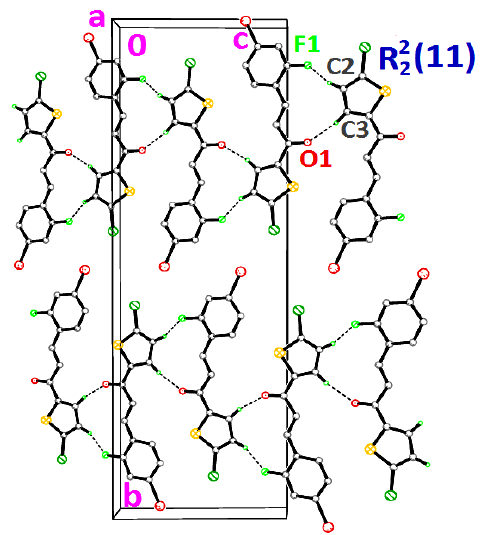
Figure 8. Crystal structure of 3f , showing the chains along the c -axis. Dashed lines indicate the intermolecular hydrogen